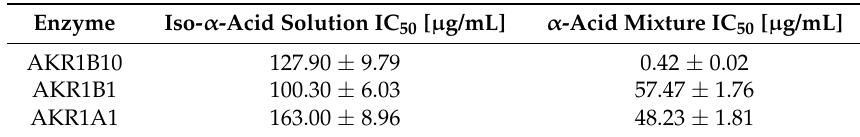
Table 1. IC 50 values of an iso- α -acid solutions and an α -acid mixture for the respective reductases. IC 50 values are presented as mean ± SD of at least three experiments.